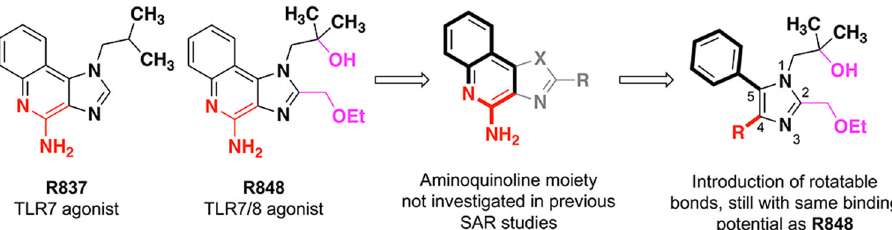
Fig. 1 Design and rationale of tetrasubstituted imidazole derivatives. The structure of R837 (a selective TLR7 agonist) and R848 (a nonselective TLR7 and TLR8 agonist) are shown. Previous SAR efforts resulted in R848 and R837 mainly focused on the 5-membered azole ring and its substituents. In this work, we broke apart the aminoquinoline ring to introduce more rotatable bonds but maintained the substituents that originally provided TLR8